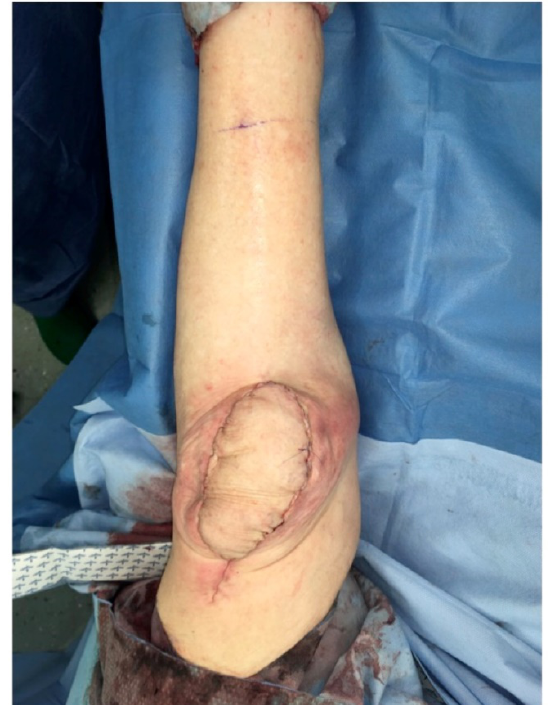
Figure 16: Pedicled MSAP gastrocnemius flap: Intraoperative view with knee in full extension after soft-tissue inset during flexion to avoid stress on the soft tissue during mobilization (Table 1: Patient No. 5; additional Figures 6, 12, 13, 14, 15, 17).